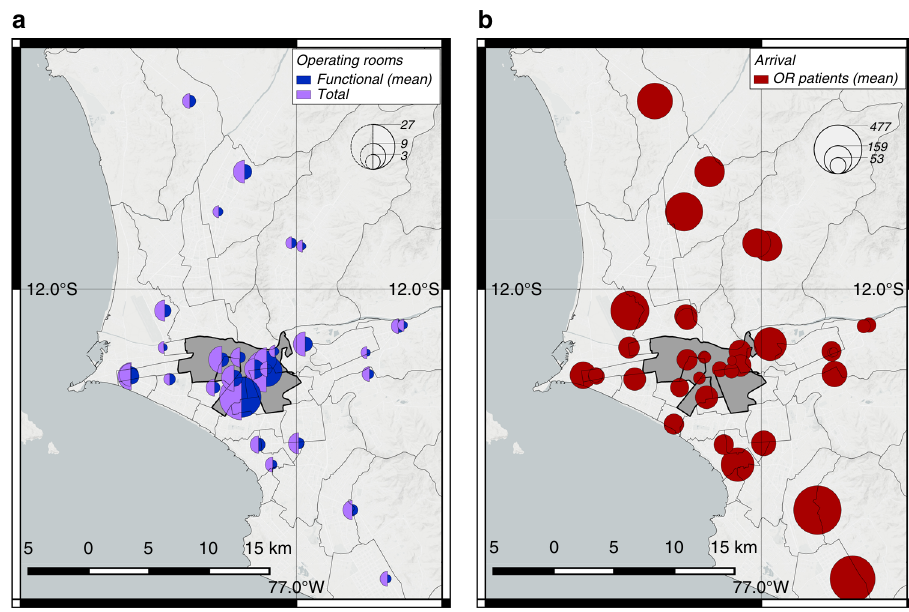
Fig. 3 Distribution of operating rooms and patient arrivals in Lima, where the circle sizes represent their relative values. a Current number of operating rooms in hospital locations 18 and mean estimates of functional operating rooms after the M 8.0 earthquake. b Mean estimates of total arrivals of patients who will need surgical procedures after the earthquake. The comparison of both plots shows that the capacity of the system is heavily centralized, whereas the demand is concentrated in the periphery of the city. Source data are provided as a Source Data fi le, and the base map layer is available under a